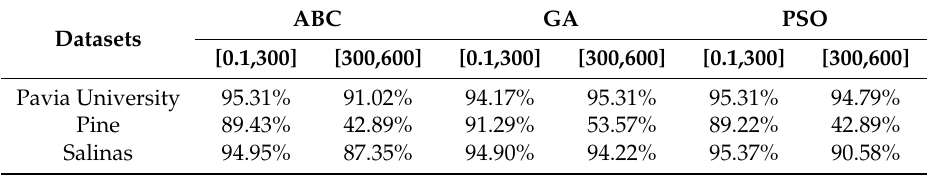
Table 4. The overall accuracy of three GI algorithms with different σ range